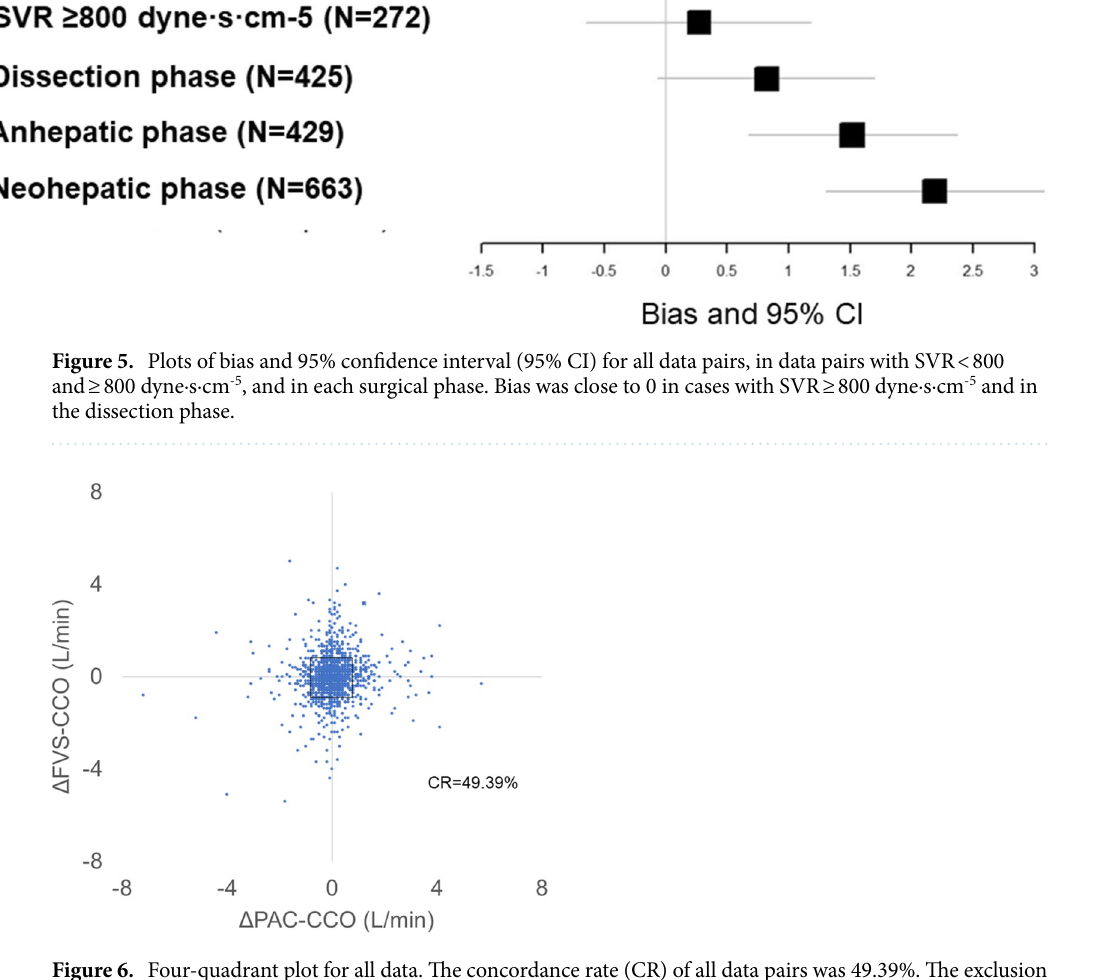
Figure 6. Four-quadrant plot for all data. The concordance rate (CR) of all data pairs was 49.39%. The exclusion zone was 0.873 L/min, which is 10% of the mean PCO.